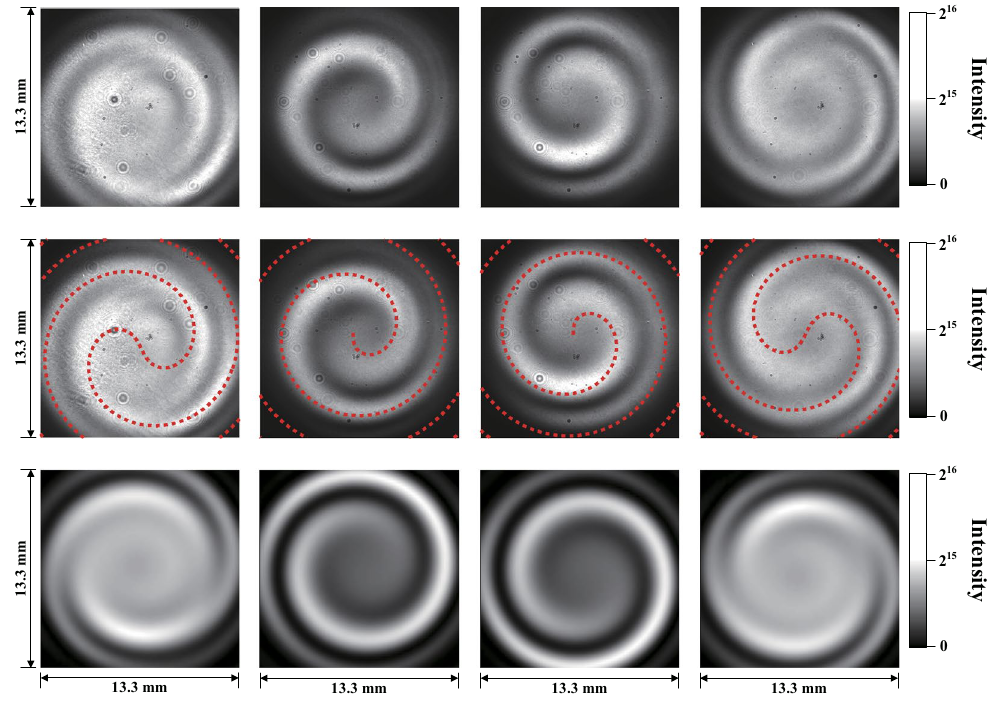
Figure 4. Interference between two undulator radiations. From the left column to the right: interference patterns between the fundamental and third harmonics and between the fundamental and second harmonics for left-handed polarisation, and between the fundamental and second harmonics and between the fundamental and third harmonics for right-handed polarisation. From the top row to the bottom, the raw CCD images, those with the analytic calculation results (red dotted lines) following Bahrdt et al . 19 and the numerical simulation results by SRW 25 . The handedness is defined along the electron beam direction. The centres of the analytic results are fitted to the